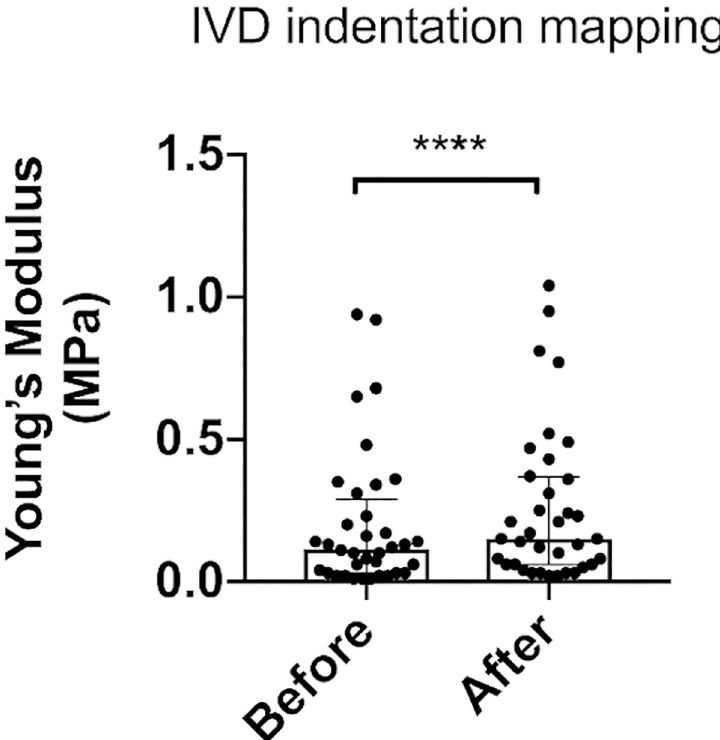
Fig 7. Automated indentation mapping of IVD tissue. The relaxation behavior of the IVD tissue was determined before and after treatment of IVD tissues with 8 mM Riboflavin followed by exposure to 3.5 mW/cm 2 UVA light (RF +UVA). A total of 6 “casted-specimens” isolated from n = 4 different caudal spine specimens, were analyzed.